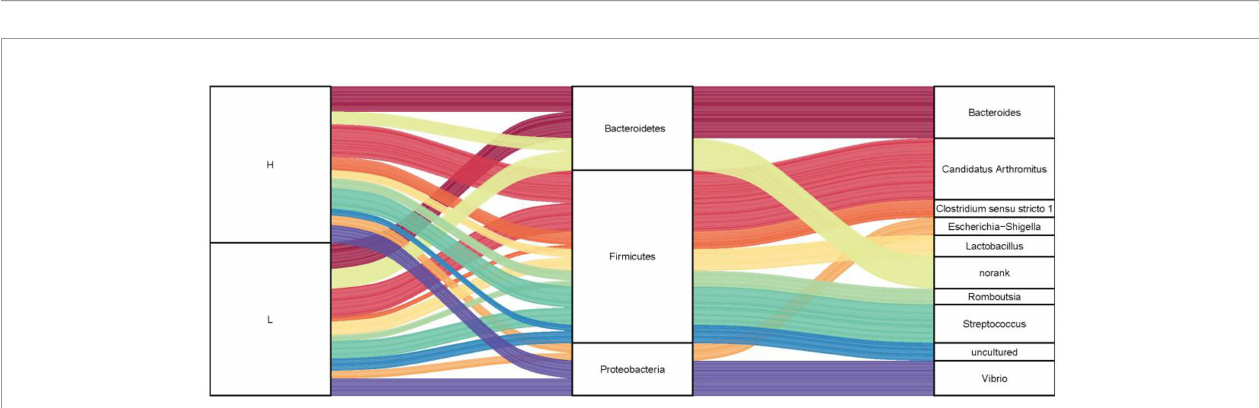
FIGURE 5 | The microbial composition of the ileum of Muscovy ducks in high and low groups. Two hundred newly hatched ducklings were fed commercial feeds for 70 days before the ileal content samples were collected from each ileum segment. The Sankey Diagram (A) was constructed with the relative abundance of OTUs to determine the bacteria composition of the ileum in the high and low groups with 40 ducks per group.